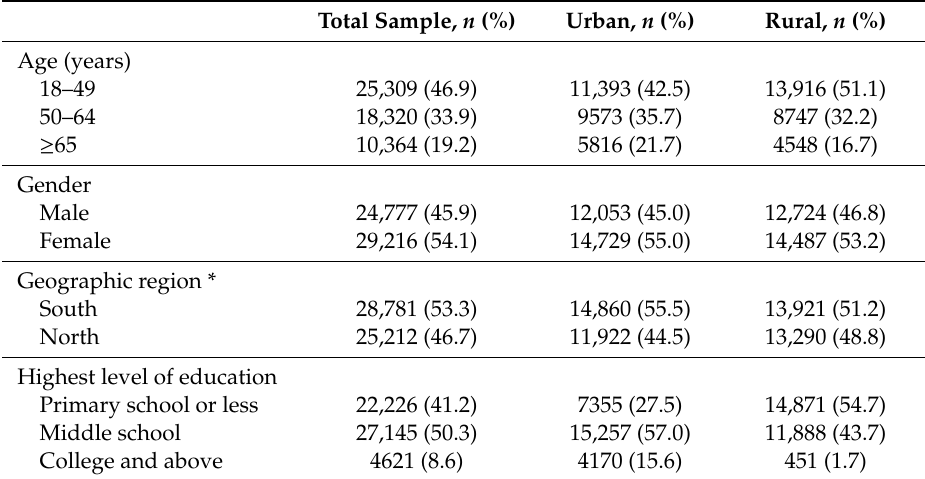
Table 1. Demographic characteristics of the 53,993